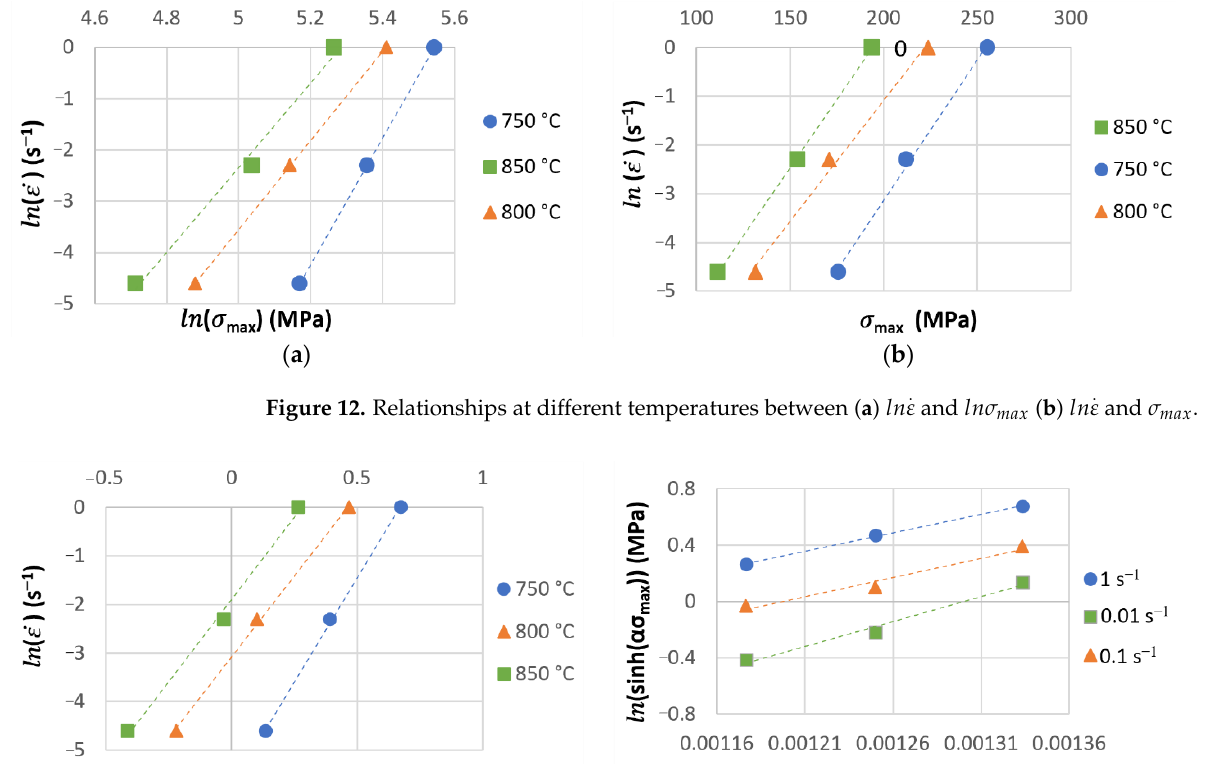
Figure 12. Relationships at different temperatures between ( a ) 𝑙𝑛𝜀̇ and 𝑙𝑛𝜎 𝑚𝑎𝑥 ( b ) 𝑙𝑛𝜀̇ and 𝜎 𝑚𝑎𝑥 .